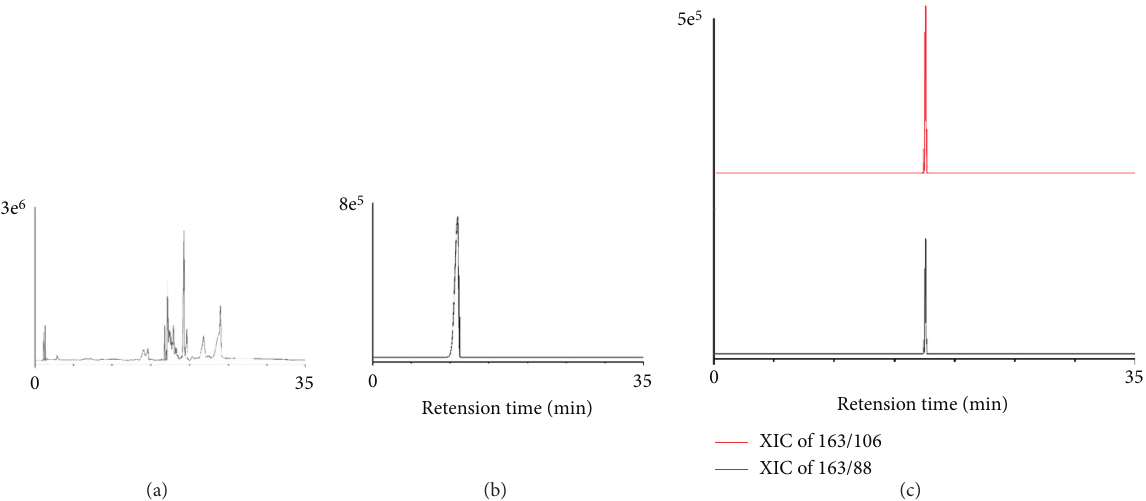
Figure 3: MRM spectrum of the tobacco sample and methomyl standard. (a) 1D-tobacco sample, (b) 1D-methomyl standard, and (c) 2D- tobacco Table 3: Recovery of methomyl in 2D-LC-MS/MS at different concentrations.